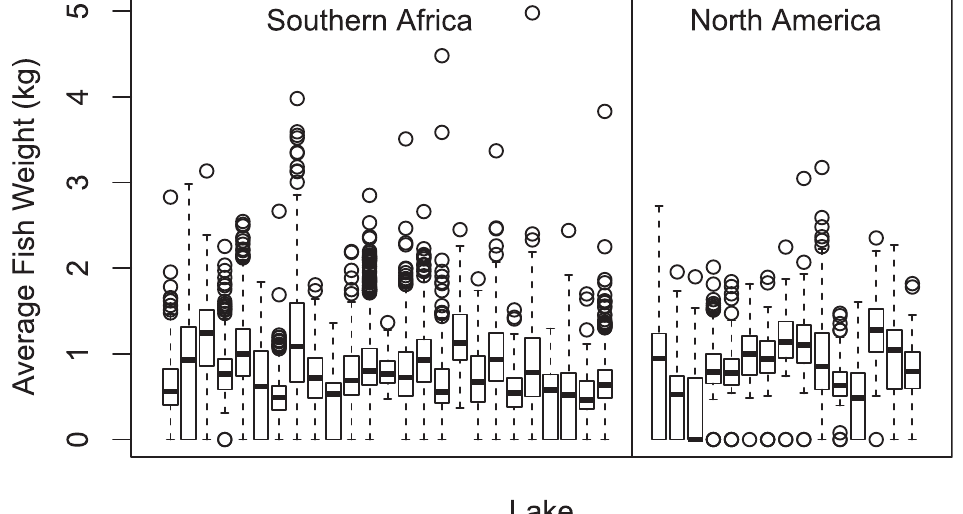
Fig 3. Catch characteristics from tournament angling events held in southern Africa and North America. The average weight of black bass ( Micropterus spp.) retained in 186 tournament angling events hosted by B.A.S.S. in North America and S.A.B.A.A. and Z.N.B.F. in southern Africa. Each column represents an individual impoundment, and boxes display the 25 th and 75 th quartiles. Dark lines in boxes indicate median values, whiskers denote the maximum and minimum values excluding outliers. Open circles represent outliers (values more than 1.5 times greater or lower than the maximum or minimum quartiles